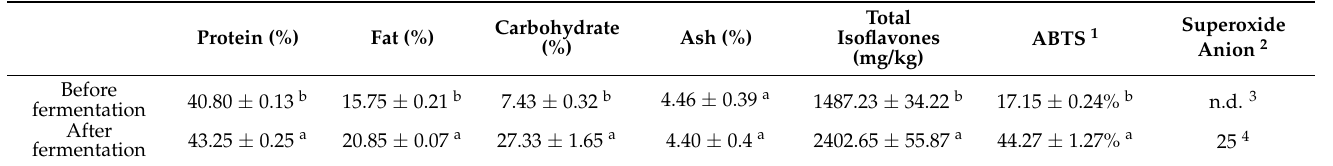
Table 1. Analysis of natto nutrition component changes (dry basis/%) and antioxidant capacity.